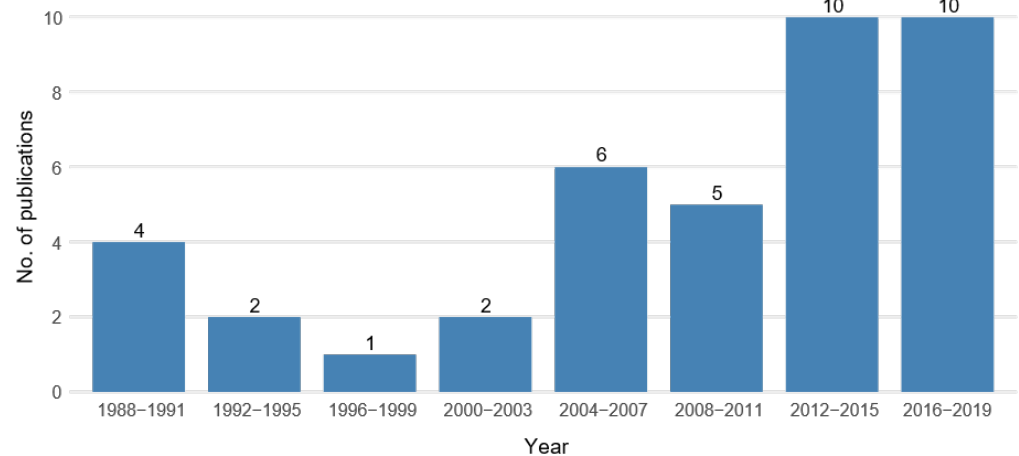
Figure 2. Geographical location of studies. ( a ) Distribution of studies according to the continents of their origin. ( b ) Distribution of studies according to their country of origin. ( n = 40 studies). * Four studies used data sets from multiple countries with high melanoma incidences for the development of their risk prediction model.